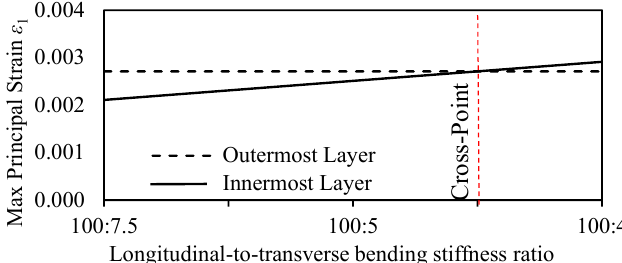
Figure 8. Maximum principal strain ε 1 distribution in inner and outer layers with respect to longitudinal/transverse bending stiffness ratio.